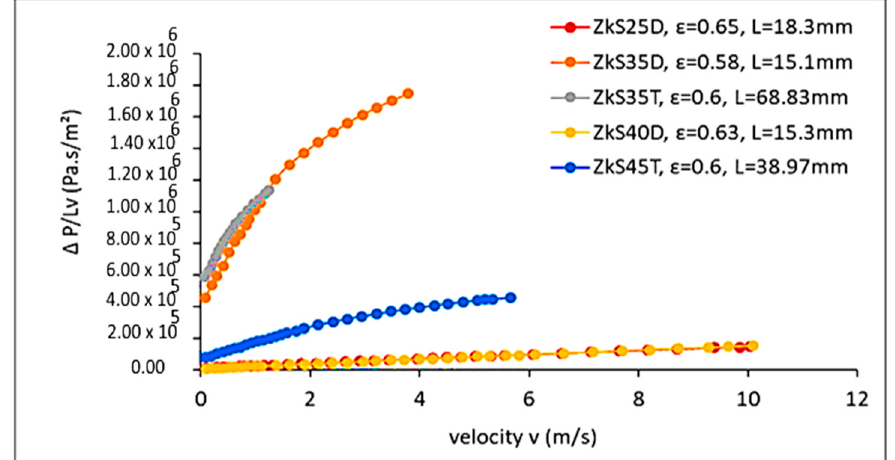
Figure 4. Reduced pressure drop vs. superficial velocity for the ESR foam samples.